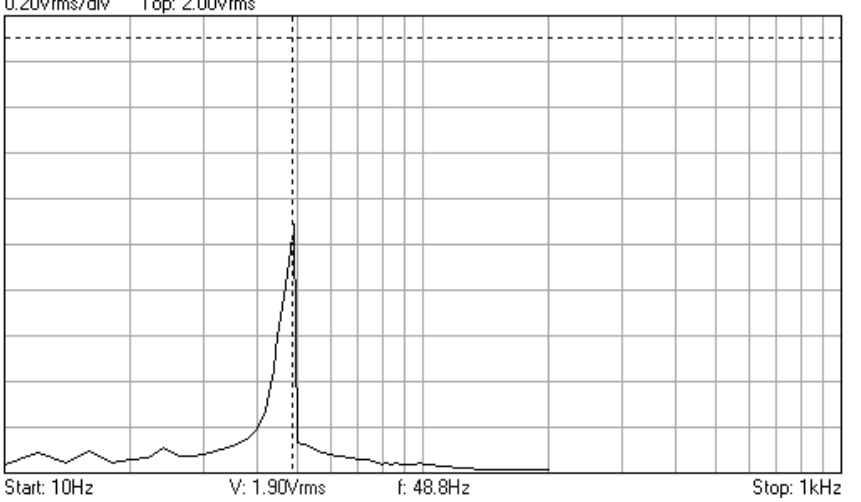
Figure 17. The last frequency at which the resonance regime could be obtained before breaking.